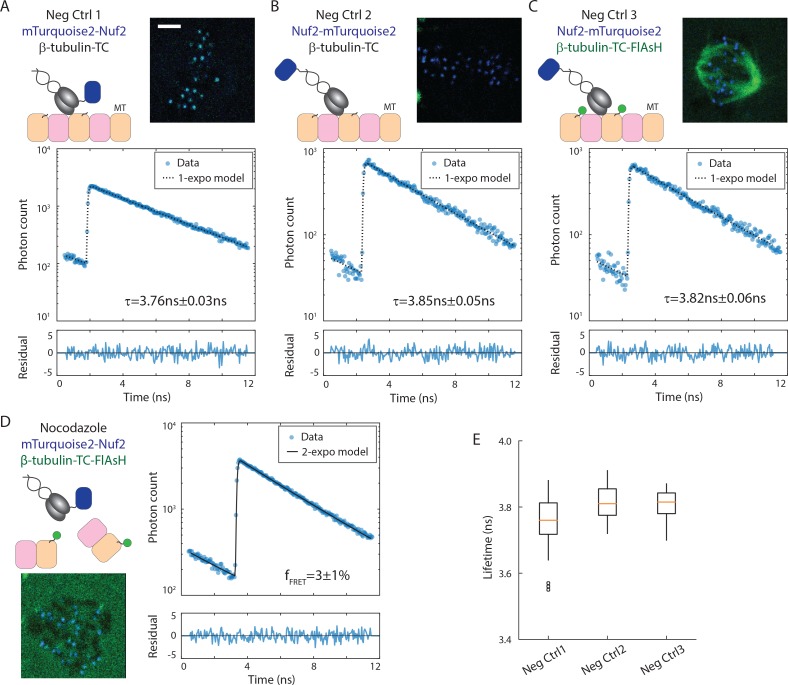
Negative control data for NDC80-kMT FLIM-FRET measurements.(A) to (D) Schematic descriptions, example cell images, and example mTurquoise2 fluorescence decay curves from three different FRET-negative control experiments and a nocodazole treatment experiment. mTurquoise2 fluorescence decay curves (blue circles) are plotted with best-fit single- (black dotted line) or two-exponential decay model (black solid line), and the associated weighted residuals are plotted below (blue curve). 3 μm scale bar. (A) Negative control 1. Nuf2 N-terminally labeled with mTurquoise2, and no FlAsH labeling. (B) Negative control 2. Nuf2 C-terminally labeled with mTurquoise2 (far from kMT), and no FlAsH labeling. (C) Negative control 3. Nuf2 C-terminally labeled with mTurquoise2 (far from kMT), and β-tubulin C-terminally labeled with FlAsH. (D) Nocodazole treatment experiment. Nuf2 N-terminally labeled with mTurquoise2, and β-tubulin C-terminally labeled with FlAsH. Cell was incubated with 5 µM nocodazole for >10 min to depolymerize microtubules. (E) Boxplot of fluorescence lifetimes estimated from single-exponential models fit to the negative control fluorescence decays. n = 32, 11, and 6 cells for Neg Ctrl 1, 2, and 3, respectively.